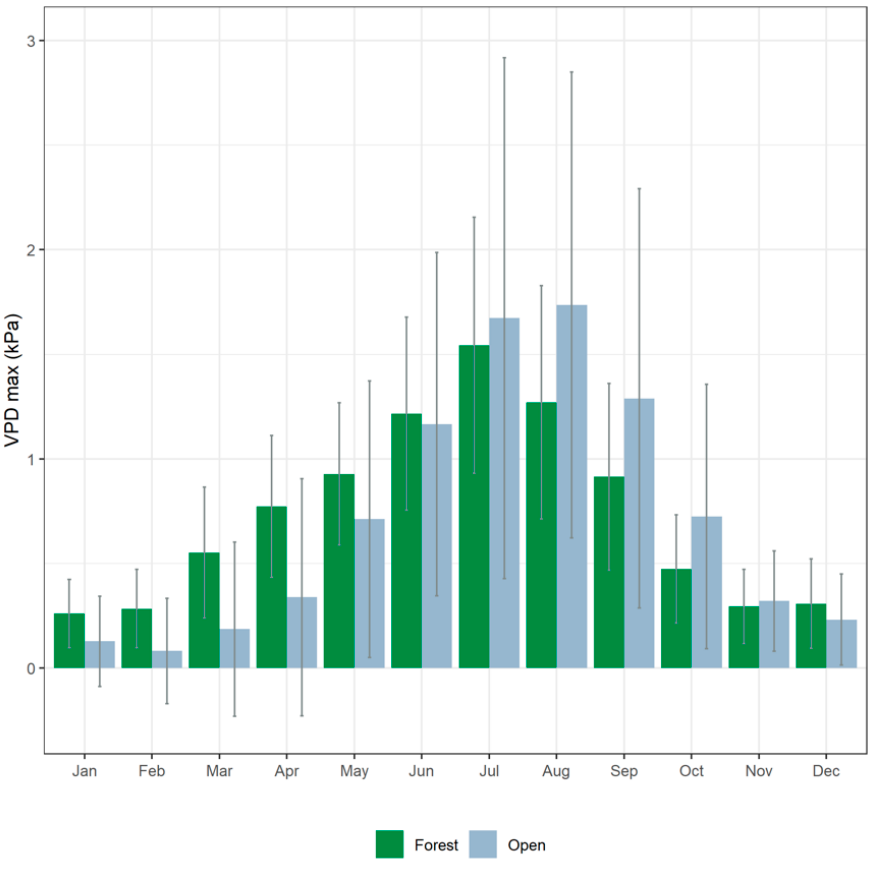
Figure 8. Histogram to compare the mean + SD of VPDmax in open and forested habitats of the PNOMP over a full year-type (see further details in text).